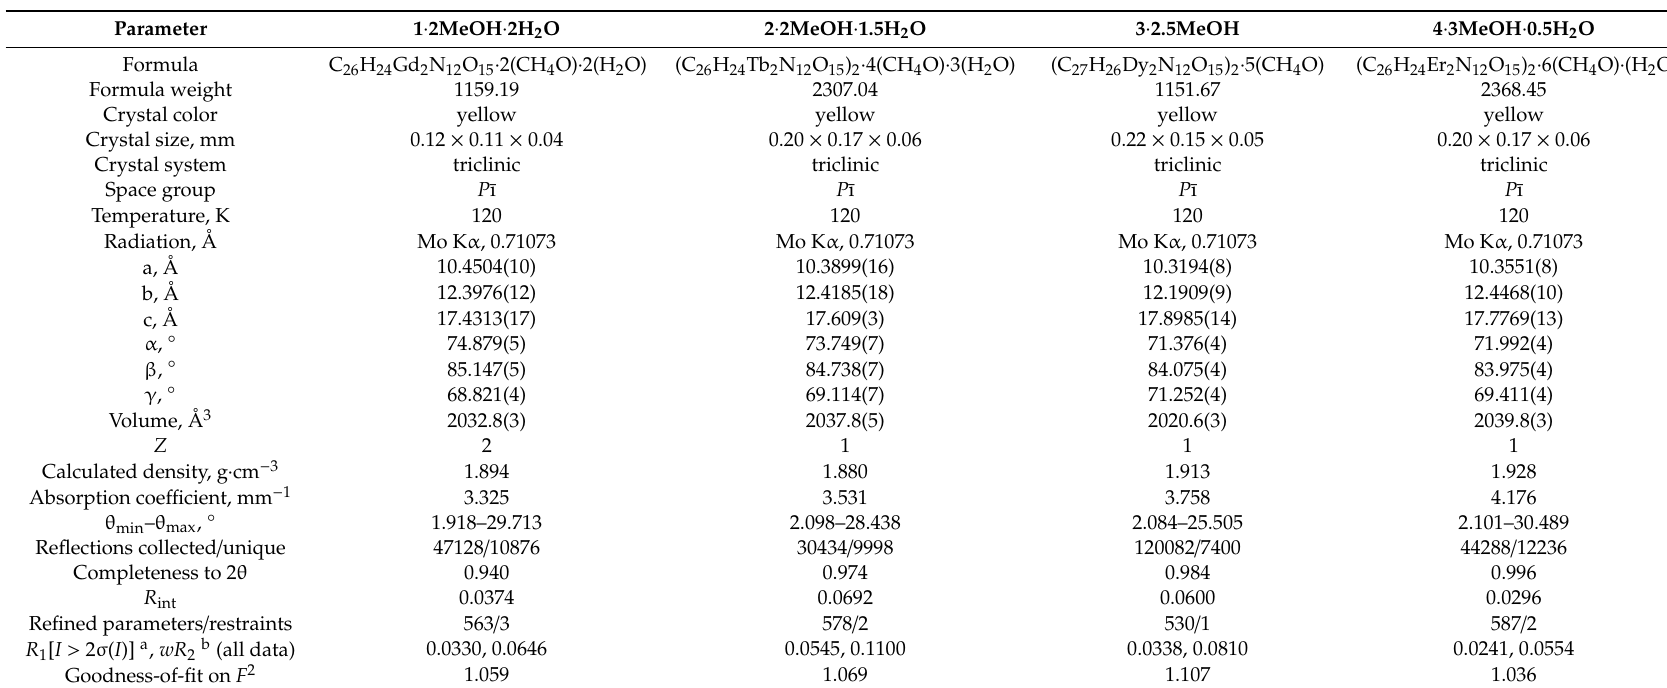
Table 1. Crystallographic data and structural refinement parameters for complexes 1 · 2MeOH · 2H 2 O, 2 · 2MeOH · 1.5H 2 O, 3 · 2.5MeOH and 4 · 3MeOH · 0.5H 2